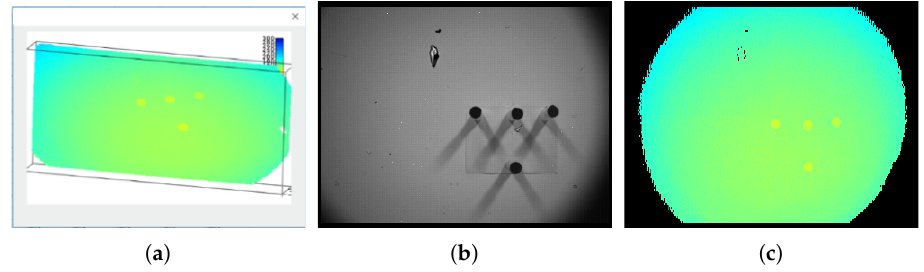
Figure 6. Data of ToF camera. ( a ) point cloud (76,800 points); ( b ) gray image; ( c ) depth